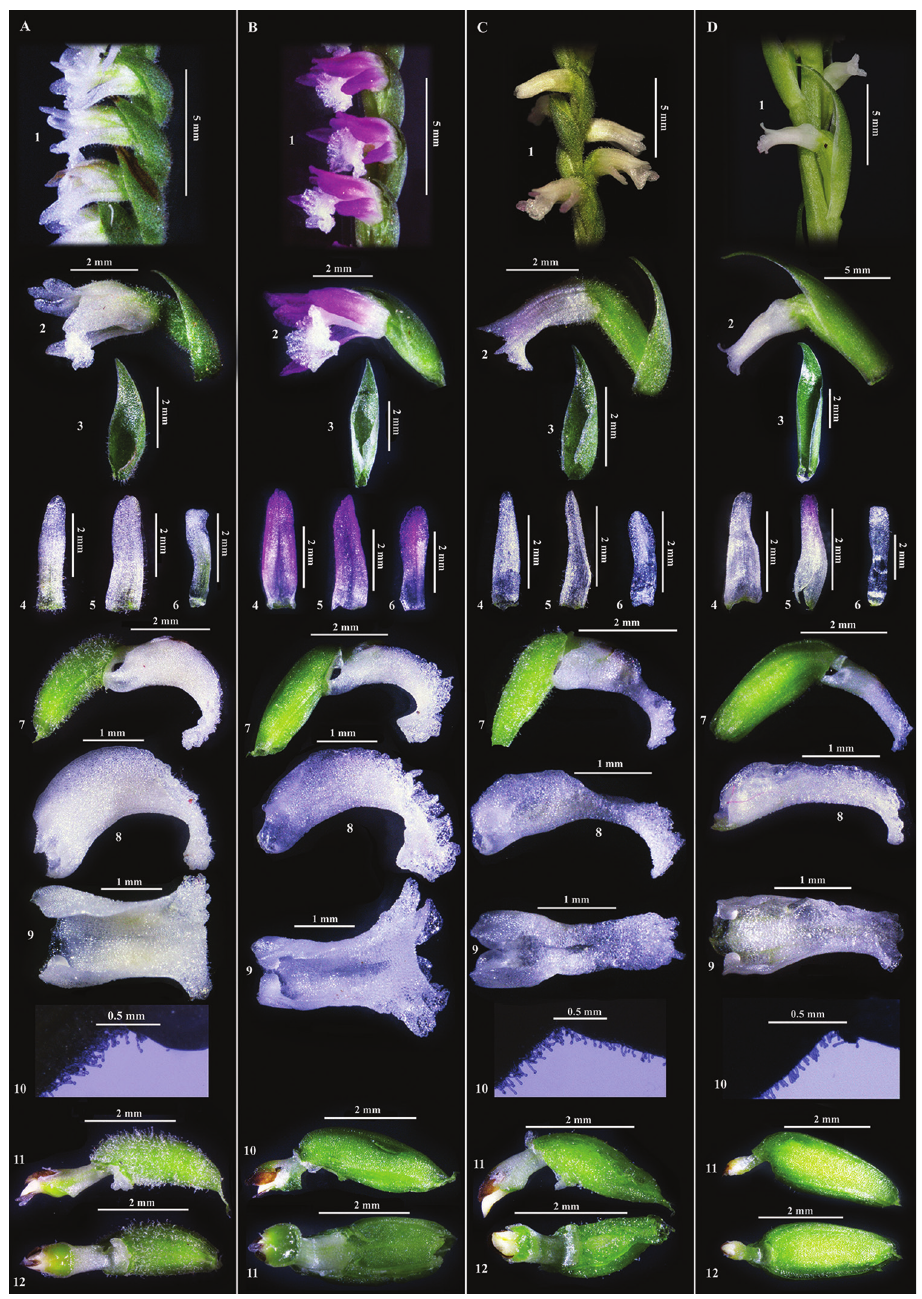
Figure 4. Comparison of morphological characters of allied species. A Spiranthes himalayensis : 1 Close- up of inflorescence 2 A flower 3 Floral bract 4 Dorsal sepal 5 Lateral sepal 6 Petal 7 Ovary with column and labellum 8 Labellum (side view) 9 Labellum (top view) 10 Close-up showing glandular hairs on label- lum and ovary 11 Ovary with column (side view) 12 Ovary with column (ventral